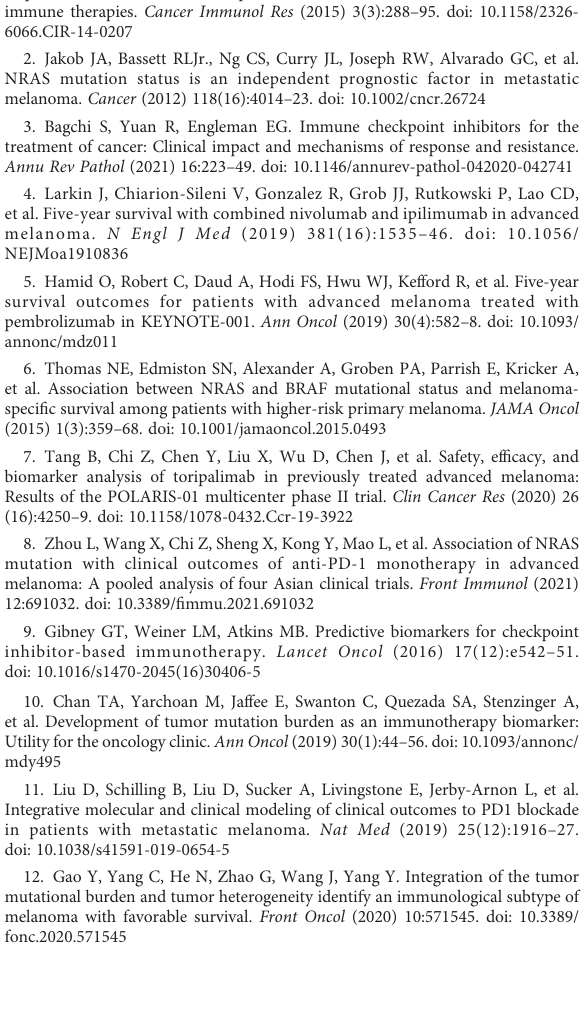
SUPPLEMENTARY FIGURE 2 The Kaplan-Meier curves of OS between NOTCH4-Mut and NOTCH4-Wt group in the non-ICIs cohort from Zehir cohort.